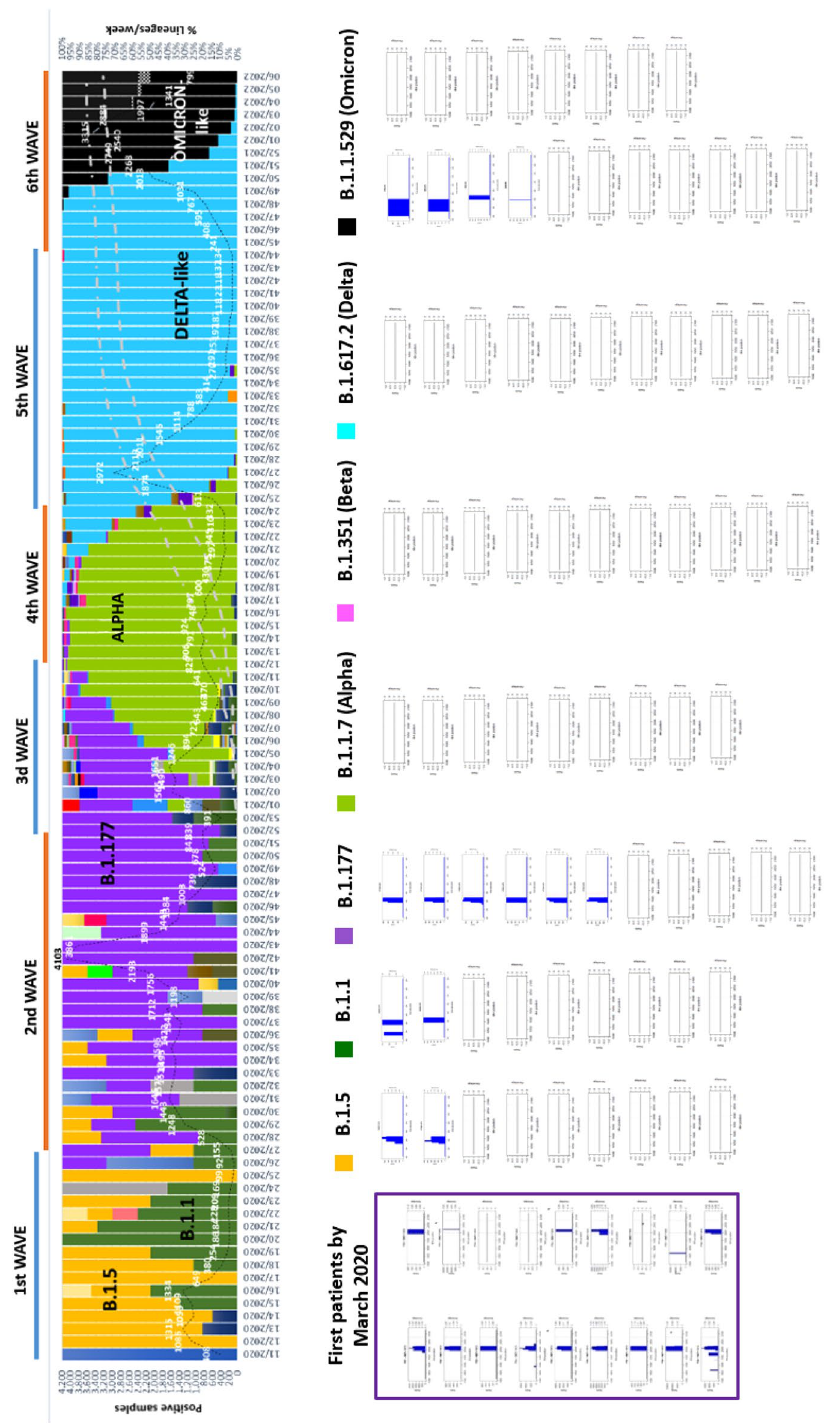
Figure 2. Lineage distribution per week and positive samples detected (discontinuous line) from March 2020 to February 2022 in Barcelona, Spain. Defective genomes are shown below the lineage distribution in bar plots starting from the first patients detected in March 2020: B.1.5 (yellow), B.1.1 (dark green), B.1.177 (violet), Alpha (light green), Beta (pink), Delta (blue), and Omicron (black). The bar plots below each variant indicate defective deletions in amplicon A78 in the 78 patients studied at the nucleotide level. The box located in the left corner are the defective bar plots related to patients in March 2020 1 . The x-axis provides the multiple alignment (MA) nucleotide positions and the amplitude of the deletions by subregions, and the y-axis shows the frequency of the deletion (percentage) on the right and the number of reads on the left. As no insertions causing defective genomes were observed, the MA positions correspond to S gene positions. Dashed lines indicate the S1/S2 (left) and S2’ (right) cleavage sites. Detailed bar plots for the 78 patients by amplicon are provided in supplementary figures (Supplementary Figures S2A−2G for deletions and 3A-3G for defective